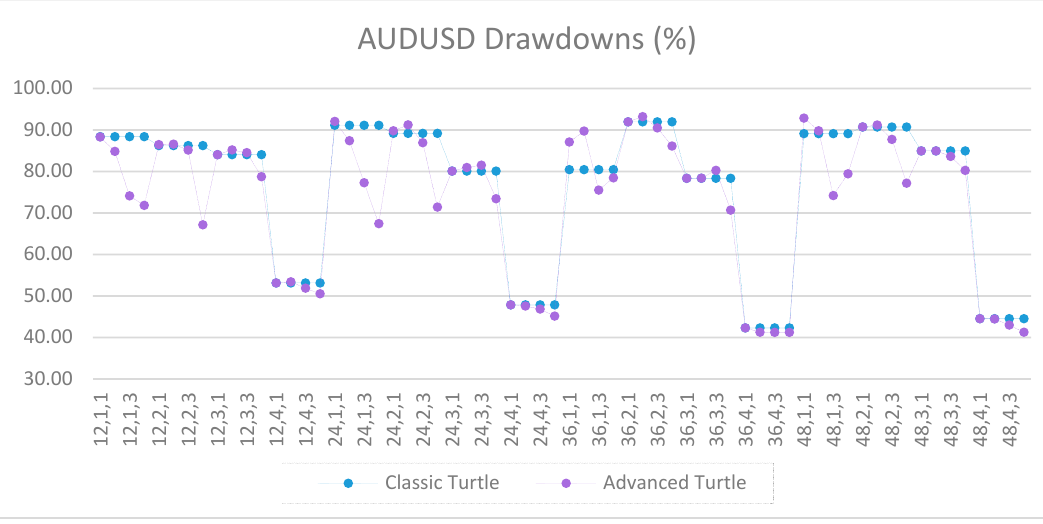
Figure A34. Drawdowns of AUDUSD as percentage of equity between the classic and the advanced Turtle systems for every combination of N, X, Y for the slow parameters (80, 160).